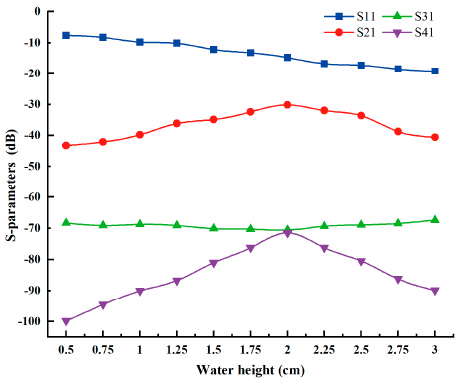
Figure 18. Figure 18. S-parameters.